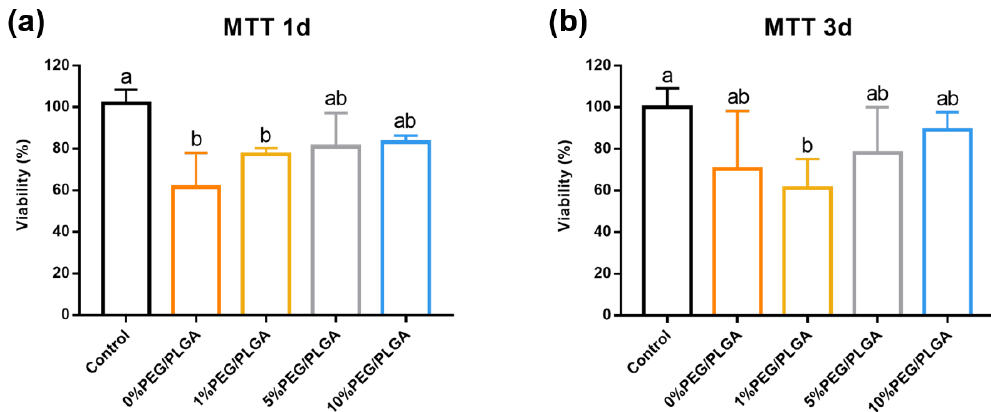
Figure 4. Biocompatibility test of the microsphere/hydrogel system. Cell viability of L929 cultured with day 1 ( a ) and day 3 ( b ), with the culture dish as the control, measured by an MTT assay. Statistical significance was marked with different letters ( p < 0.05). Abbreviations: MTT, 3-(4,5-dimethylthiazol-2-yl)-2,5-diphenyl-2H-tetrazolium bromide.